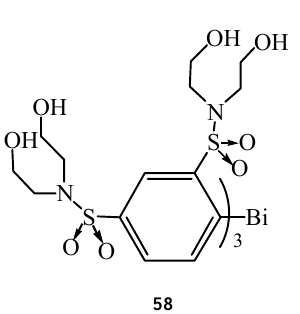
Figure 2. Compound 58